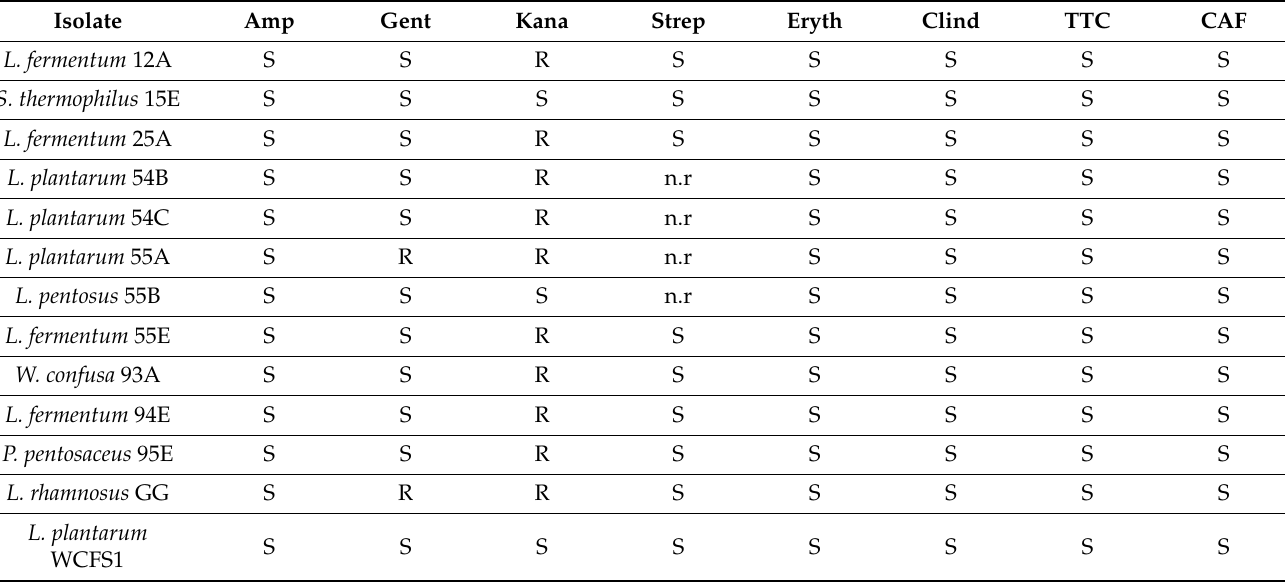
Table 3. Antibiotic susceptibility profile of potential probiotic strains from dairy